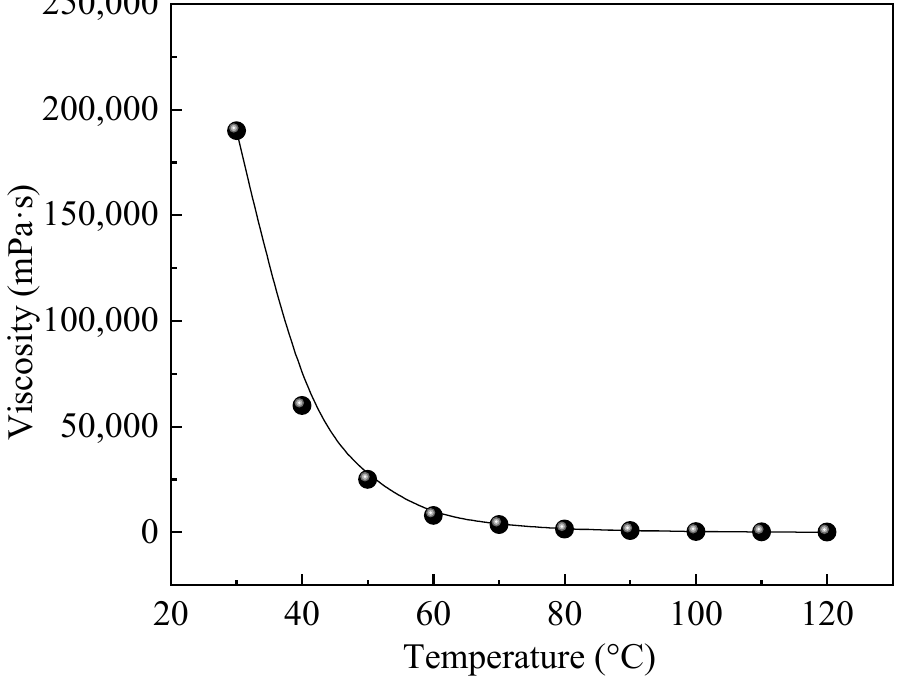
Figure 1. The relationship between the viscosity and temperature of the heavy oil used in the exper- iment.